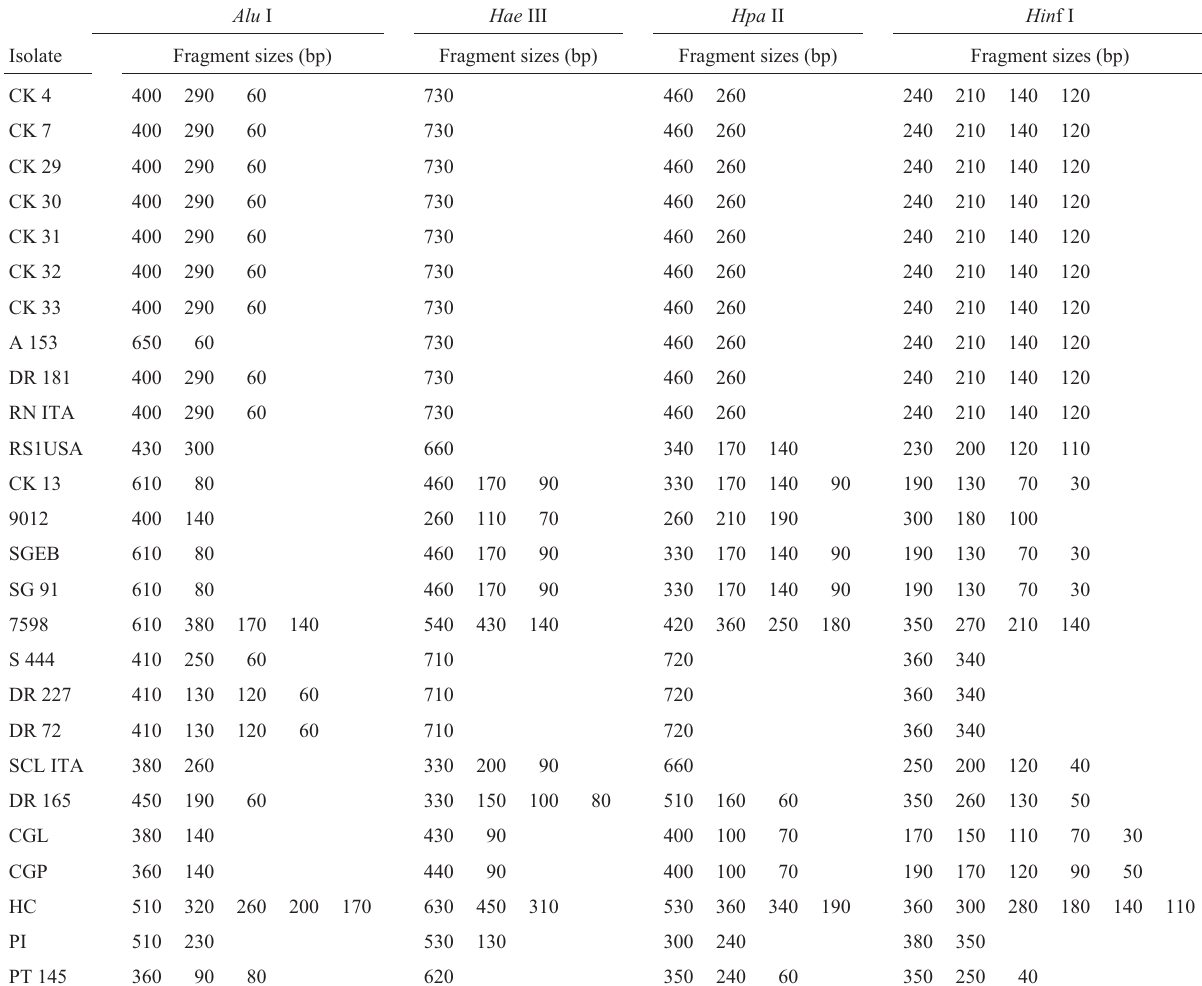
Table II - Restriction fragments (pair bases) of the internal transcribed spacer (ITS) rDNA amplified regions of ectomycorrhizal fungi isolates produced by different restriction enzymes. Alu I Hae III